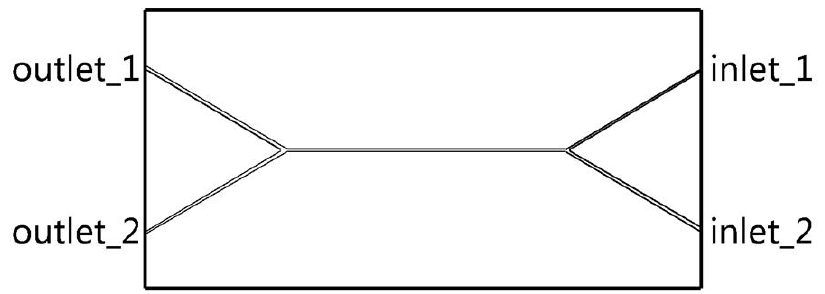
Figure 12. Multiple crossed fractures model.